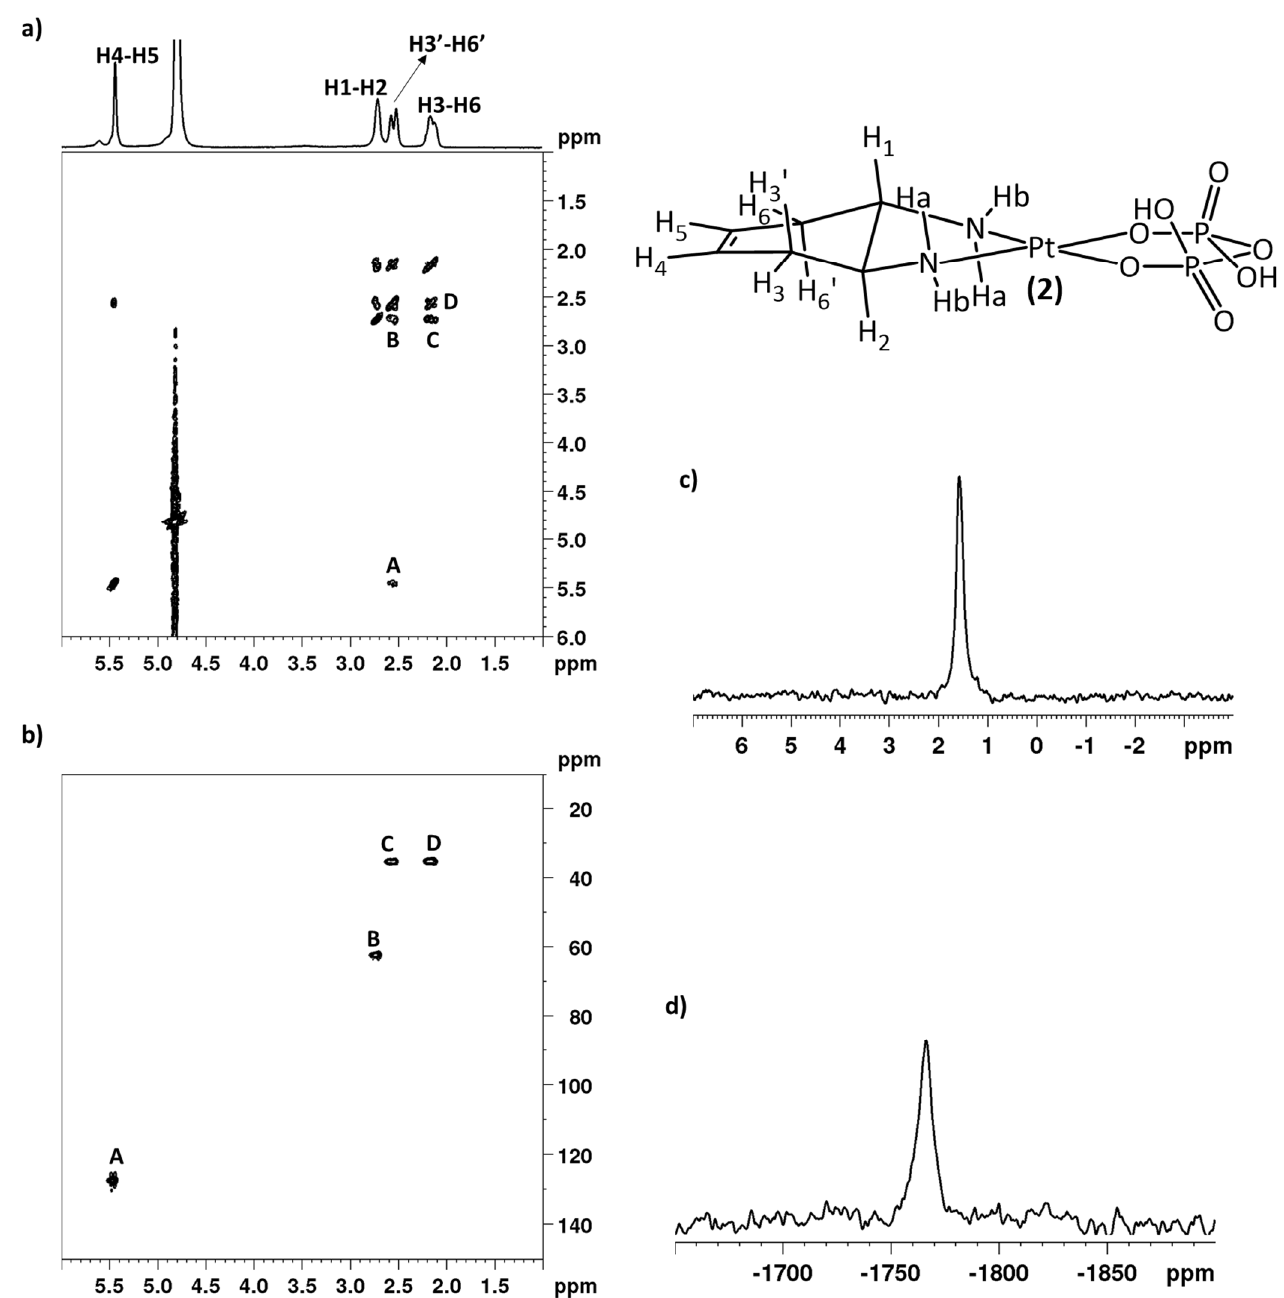
Figure 3. ( a ) COSY (300 MHz), ( b ) [ 1 H- 13 C] HSQC (75.5 MHz, 13 C), ( c ) 31 P{ 1 H} (121.5 MHz), and ( d ) 195 Pt{ 1 H} (64.5 MHz) NMR spectra of 2 in D 2 O (pH* = 9).